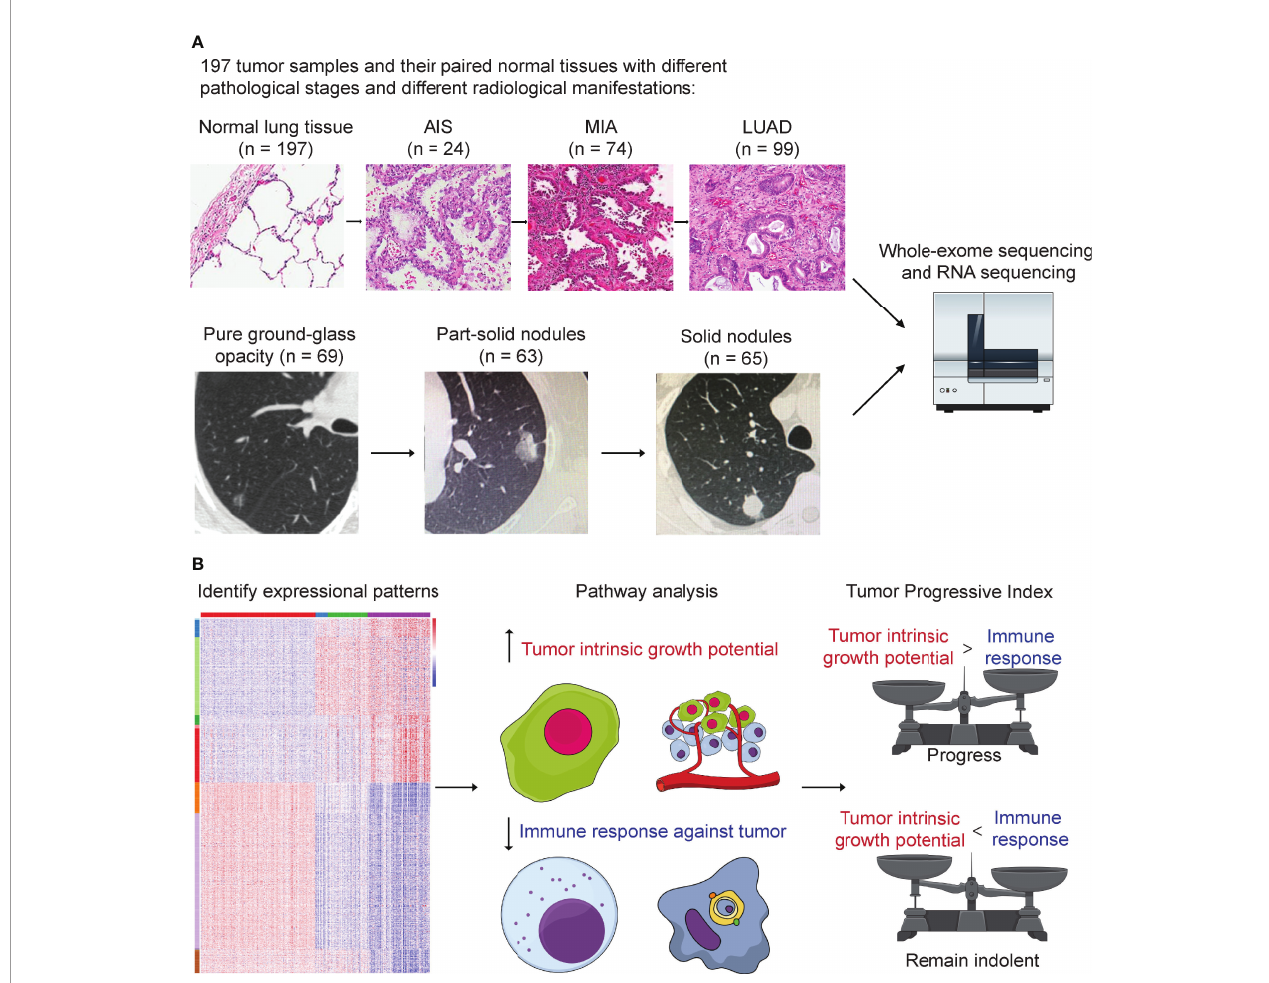
FIGURE 1 | Study design. (A) A total number of 197 tumor samples, including 24 adenocarcinoma in situ (AIS), 74 minimally invasive adenocarcinoma (MIA), 99 lung adenocarcinoma (LUAD), and their paired adjacent normal lung tissue underwent whole-exome sequencing and RNA sequencing. Genomic and transcriptomic data were analyzed and compared among different groups. Samples were further divided into three groups according to their radiological manifestations: 69 pure ground-glass opacities (GGOs), 63 subsolid nodules, and 65 solid nodules. (B) Identi fi cation of 12 expressional patterns and development of tumor progressive index based on genomic and transcriptomic